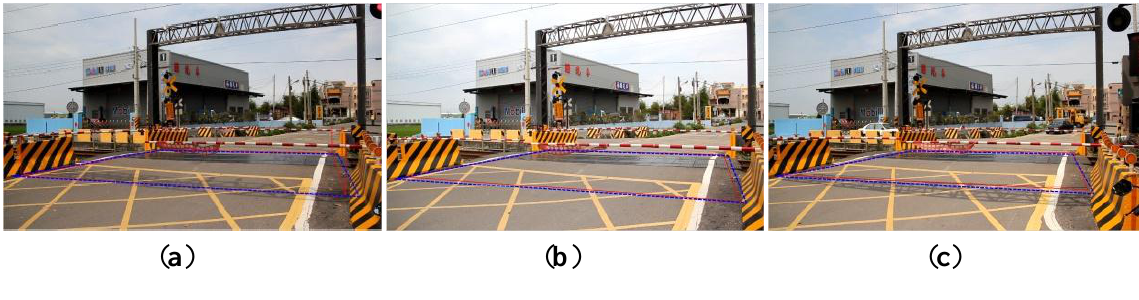
Figure 18. The detection result of the risk area corresponding to case-4, the Danjan Road; the blue-line area is the detection result, and the red-line area is the real measured result: ( a ) the measurement result with the camera mounted in the standard position; ( b ) the measurement result with the camera moved forward 50 cm; ( c ) the measurement result with the camera moved backward 50